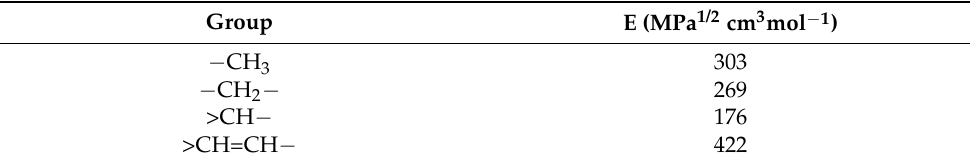
Table 3. Values of molar attraction constants [55,57].